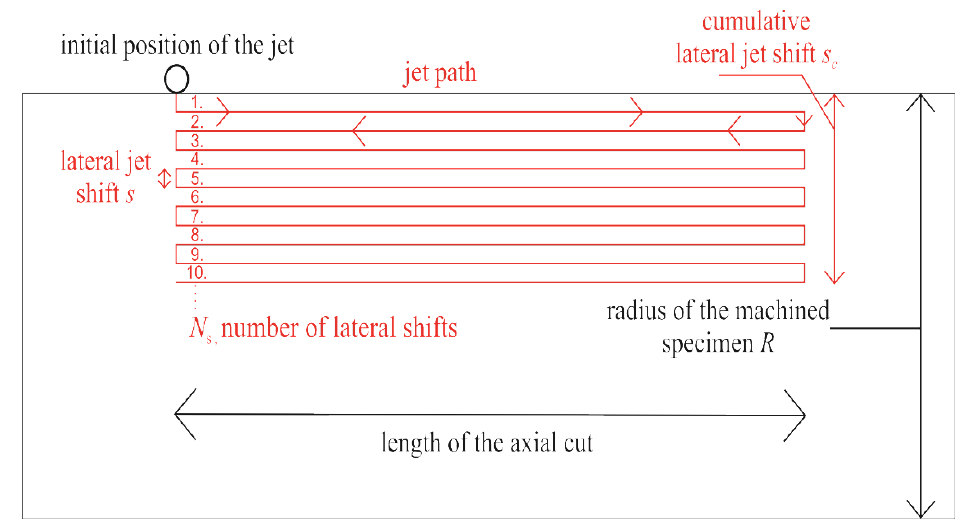
Figure 5. Top view of the jet trajectory during AWJ turning of the rounded specimen.